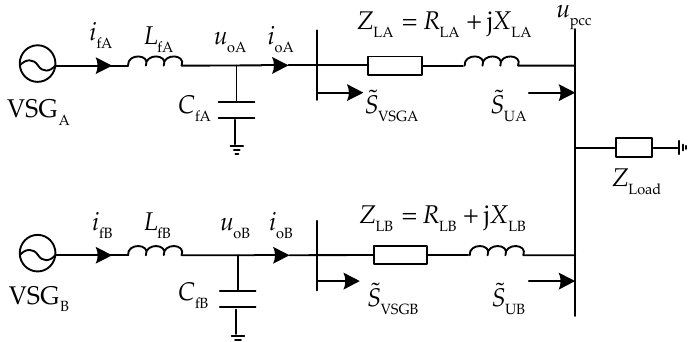
Figure 5. Equivalent diagram of parallel system of double self-synchronizing voltage sources.